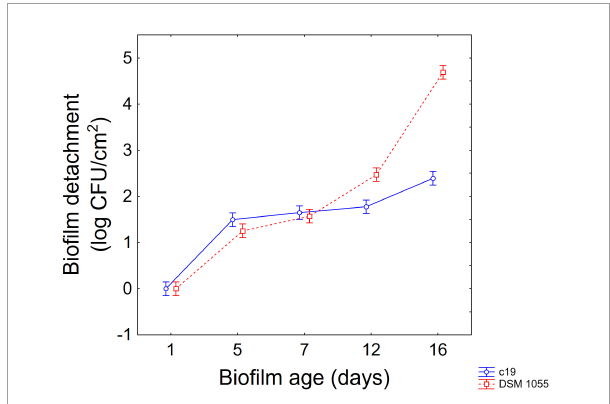
FIGURE4 Decomposition of statistical hypothesis related to the interactive term “strain × biofilm age” on the detachment of biofilm (log CFU/cm 2 ) of L. plantarum c19 and DSM 1055. Mean values ± 95% confidence interval.